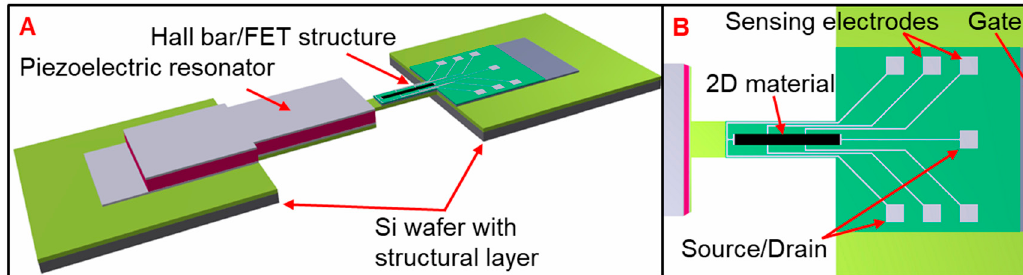
Figure 1. Proof of concept and principle of proposed structure (not to scale): ( A ) MEMS piezoelectric resonator mechanically linked to stretching Hall bar/FET structure; ( B ) The detail of stretching part with 2D material using Hall Bar/FET structure for electric measurements of 2D material properties.